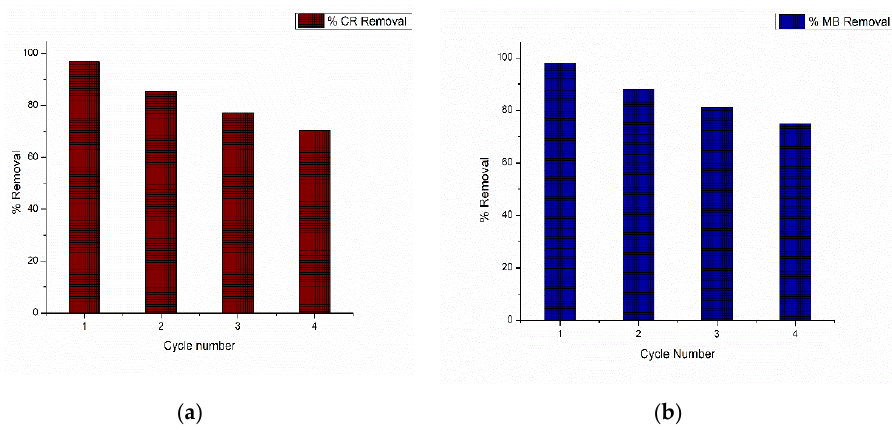
Figure 11. The percentage of elimination of dyes ( a ) CR and ( b ) MB as a function of cycle number using chitosan–graphene oxide-electrosprayed PAN–EN membrane .